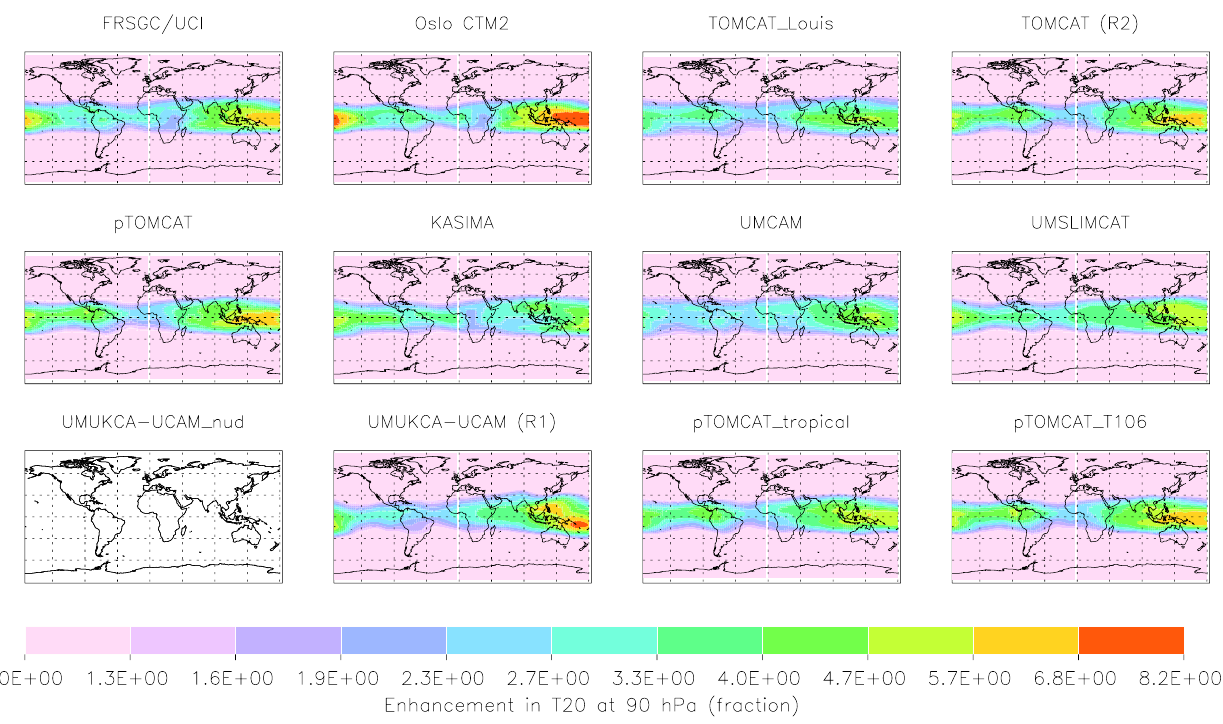
Fig. 6. The fraction enhancement of the 2005 annual mean mixing ratio of the T20 tracer, for each model at the 90hPa level. No data was available at this level for UMUKCA-UCAM nud. The enhancement was calculated by dividing the value at a particular point by the global mean at that